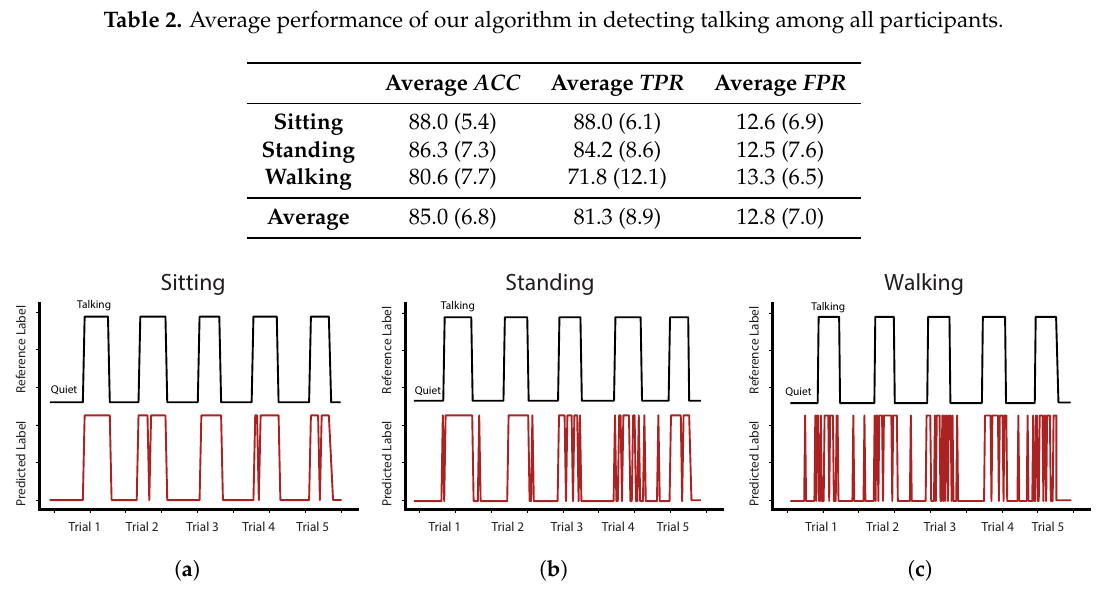
Figure 7. Exemplary detection of talking for participant P10 in activities: ( a ) sitting; ( b ) standing; and ( c )